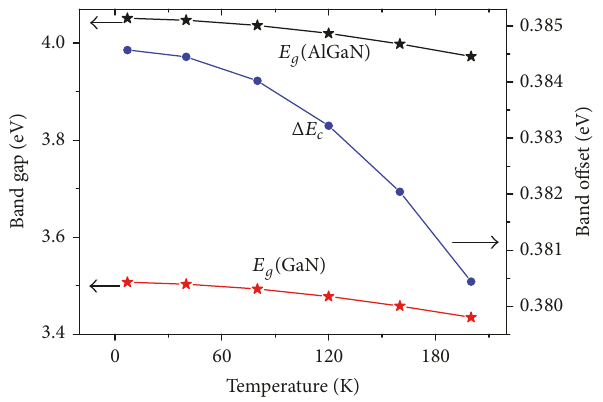
Figure 4: Temperature dependence of the energy band gaps of AlGaNandGaNandtheconductionbandoffsetofAlGaN/GaNhet- erostructure.